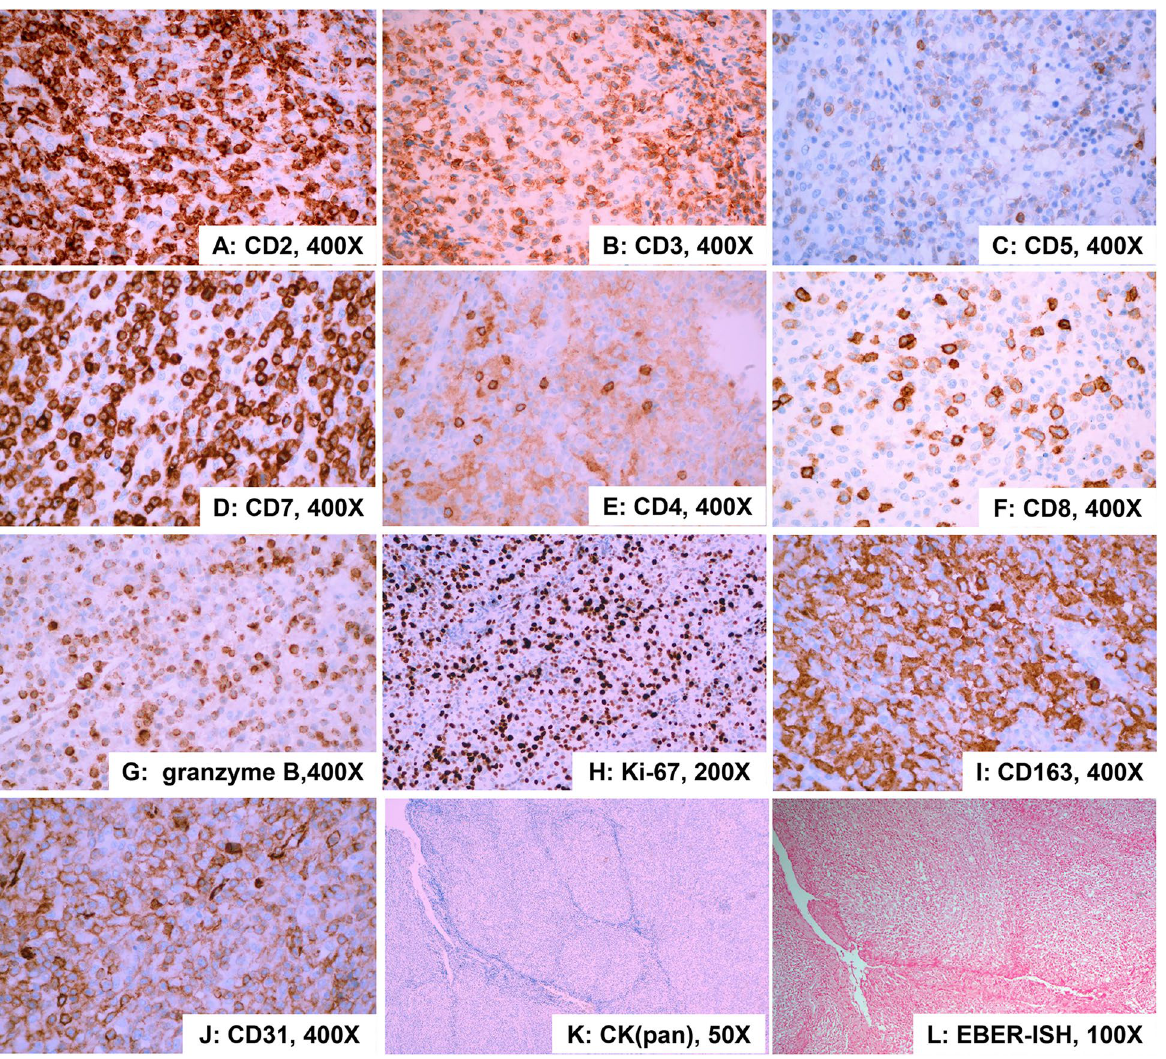
Fig. 3 Immunohistochemical findings and EBER in situ hybridization. Immunohistochemical stains in small lymphocytes for CD2, CD3, CD5 (a few), CD7, CD4 (a few), CD8, and granzyme B are positive. Over-expressed for Ki-67. Immunohistochemical stains in epithelioid cells for CD163 and CD31 are diffusely positive, and negative for CK(pan). In situ hybridization for EBER was negative. ( A CD2, 400 ; B CD3, 400 ; C CD5, 400 ; D CD7, 400 ; × × × × E CD4, 400 ; F CD8, 400 ; G granzyme B, 400 ; H Ki-67, 200 ; I CD163, 400 ; J CD31, 400 ; K CK(pan), 50 ; L EBER-ISH, 100 × × × × × × × ×